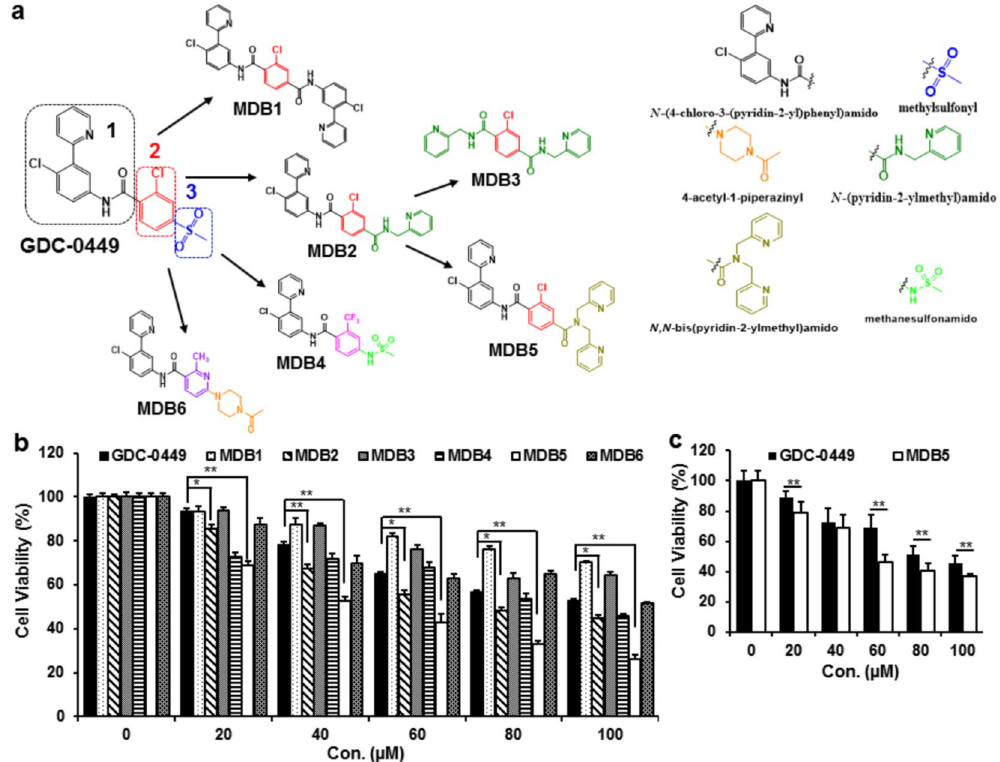
Figure 2. ( a ) Structure-activity relationship (SAR) to design GDC-0449 analogs. ( b , c ) Cell cytotoxicity assay of MIA PaCa-2 and PANC-1 cells treated with free drugs. Percentage of viable cells were estimated by MTT assay. Data is shown as the mean ± S.D. of three separate experiments (Student t-test; * p < 0.05 ; ** p < 0.001 ; n = 3 ).